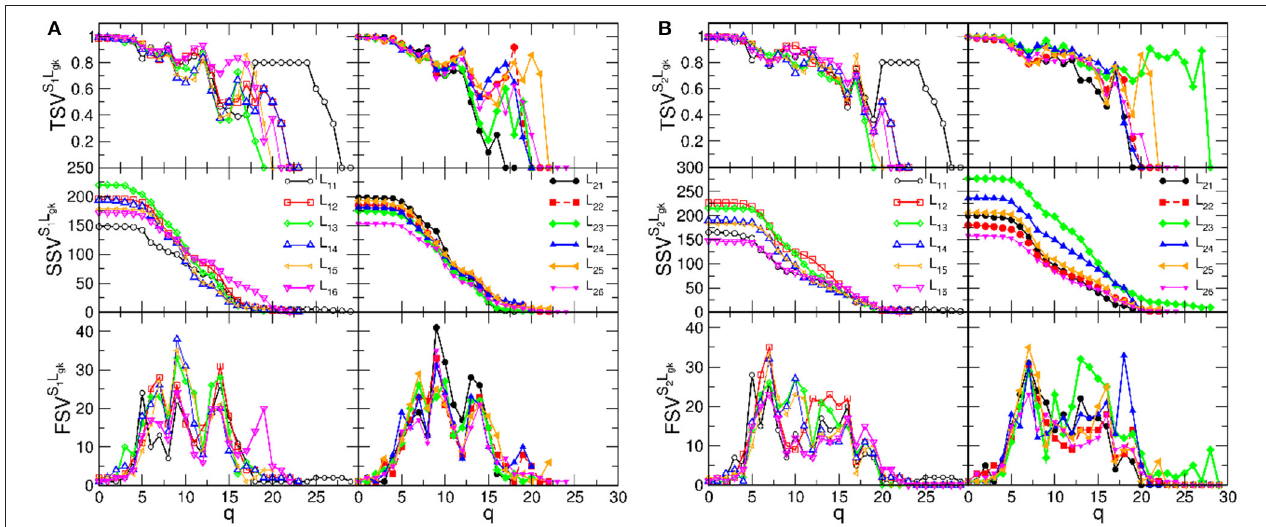
FIGURE 6 | The components of the structure vectors plotted against the topology level q for B2BCN of various speaker-listener pairs. (A) Is for the speaker S 1 paired with the listeners in group-1, left panels, and group-2, right panels. (B) Shows the corresponding vectors for same groups of listeners with the speaker S 2 .